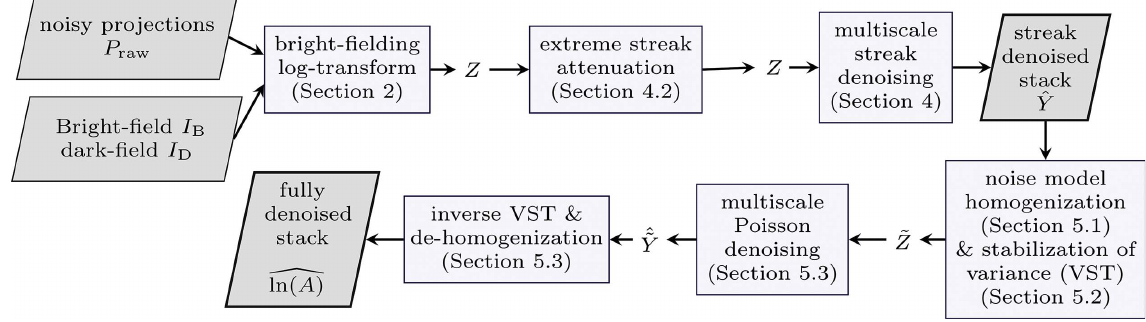
Figure 3 The full denoising process, requiring as inputs the noisy projections P raw and the bright- and dark-fields I B , I D , (1) and producing as the output an estimate d ln ð A Þ ln ð A Þ (30) of the underlying stack of projections ln( A ) (3). As an intermediate output, an estimate ^ YY (12) of the streak-free yet noisy stack of projections Y (5) is also